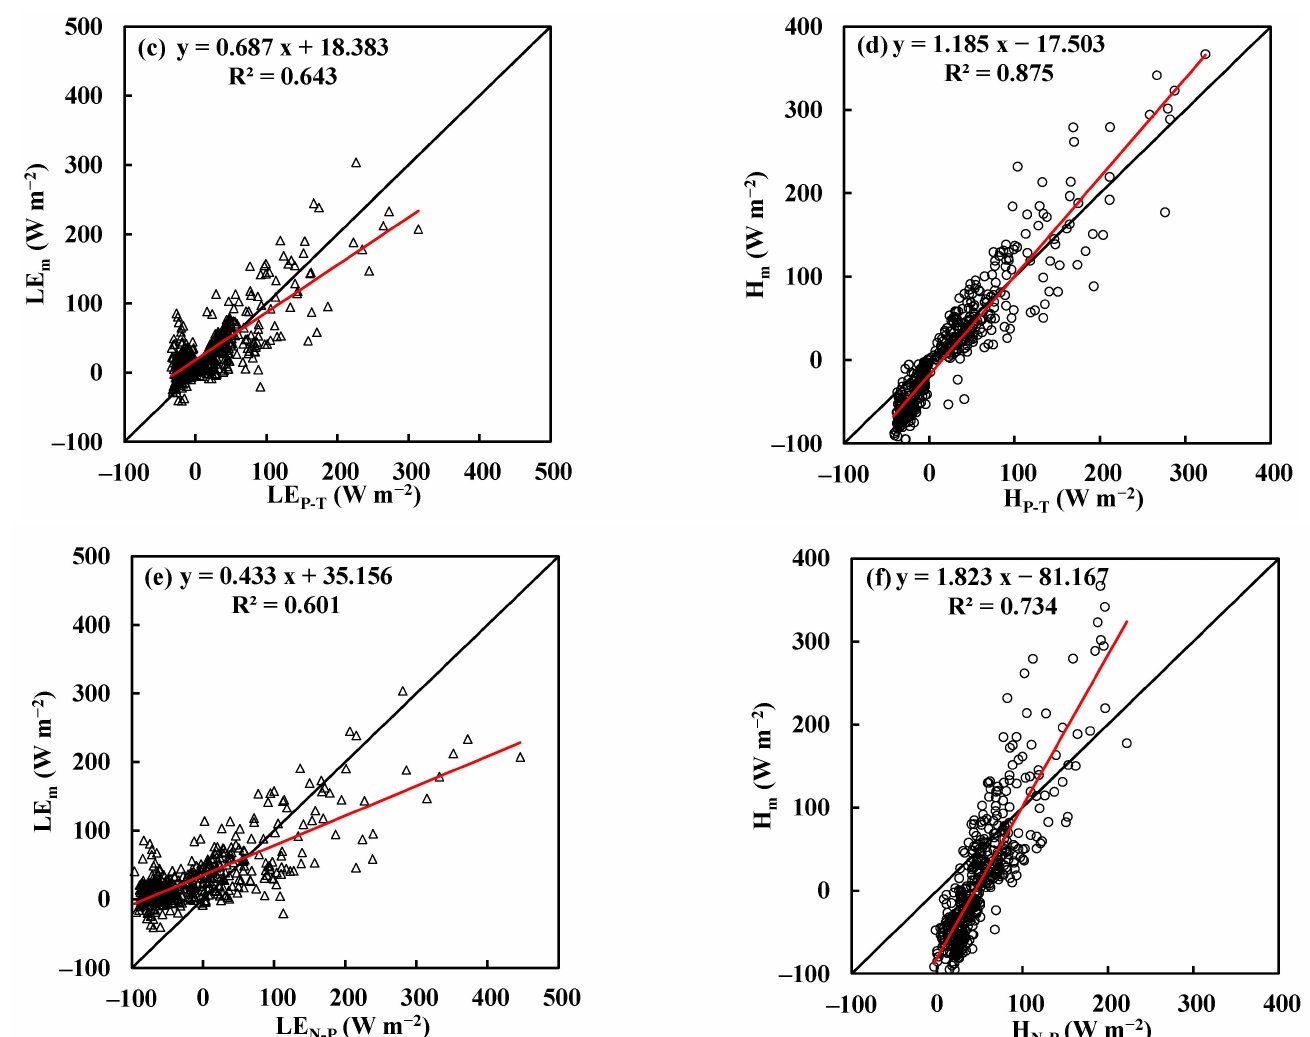
Figure 8. Comparisons of measured and predicted LE and H by the P–M equation ( a , b ), P–T equation ( c , d ), and non-parametric method ( e , f ) above the forest. The 1:1 line is also shown.